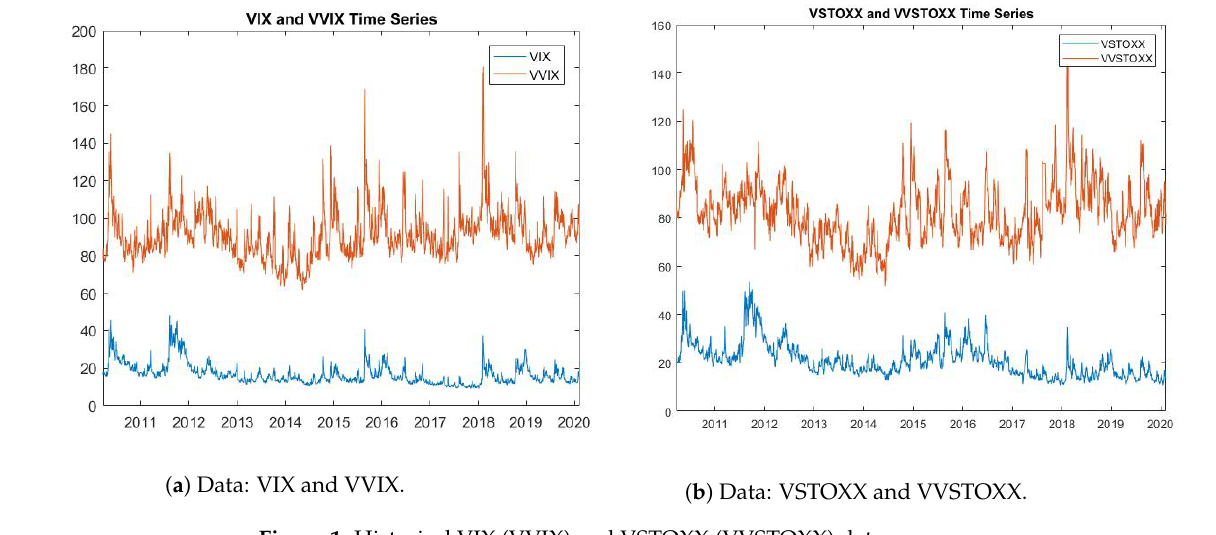
Figure 1. Historical VIX (VVIX) and VSTOXX (VVSTOXX) data.